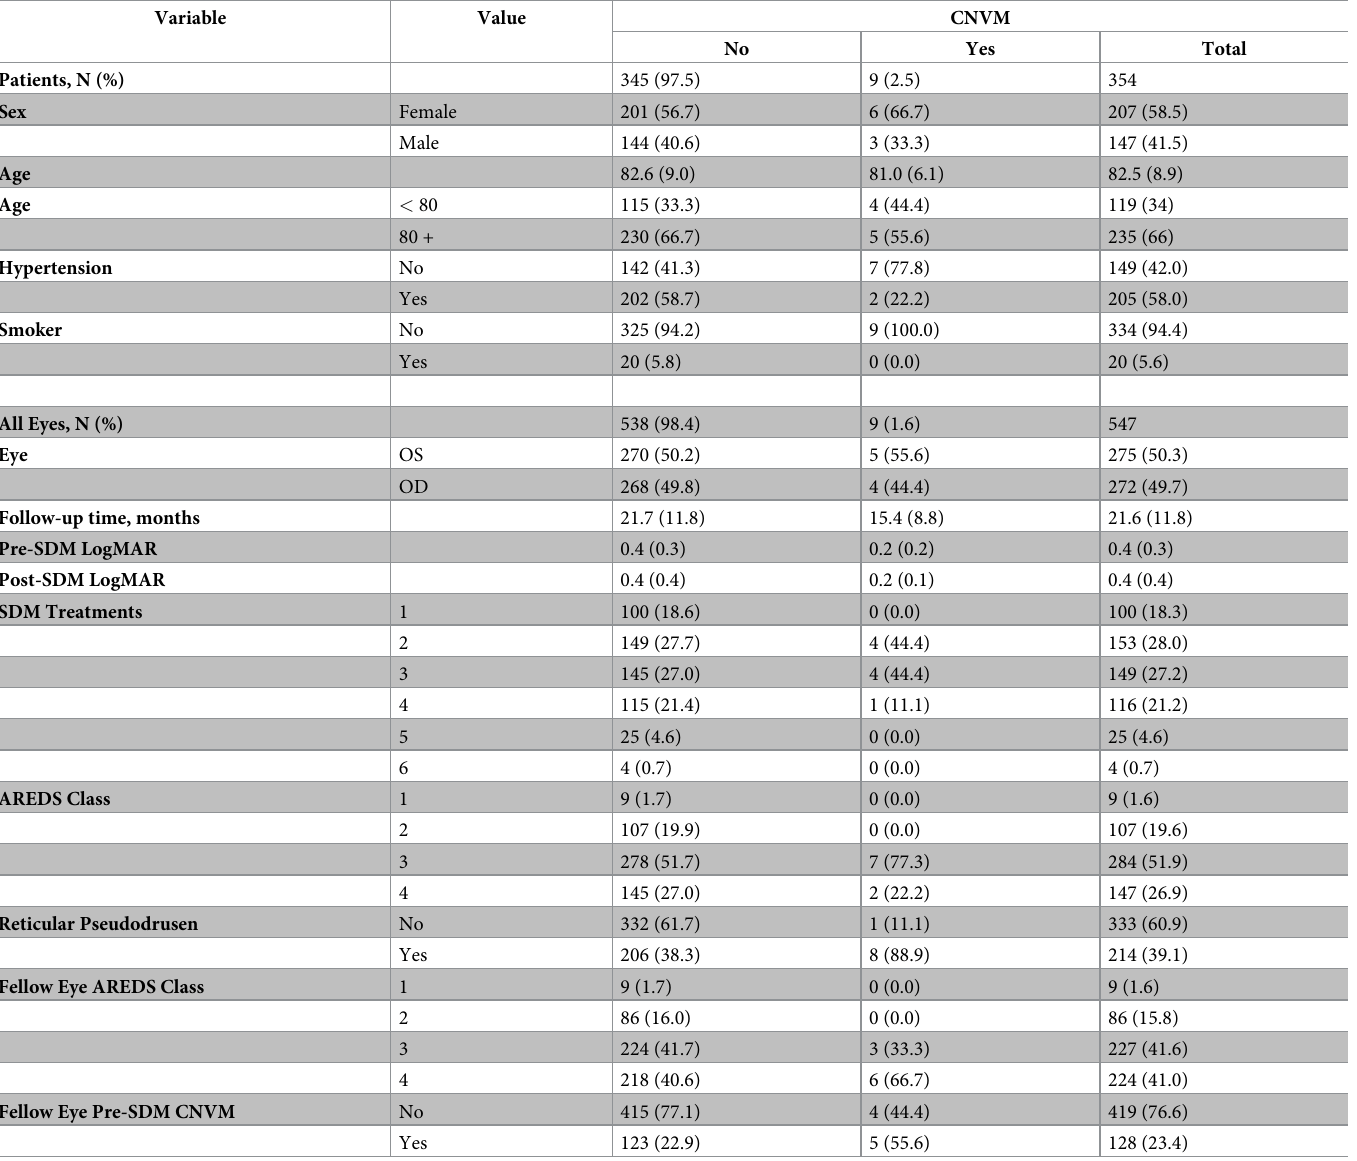
Table 1. Descriptive statistics of patient and eye level variables by